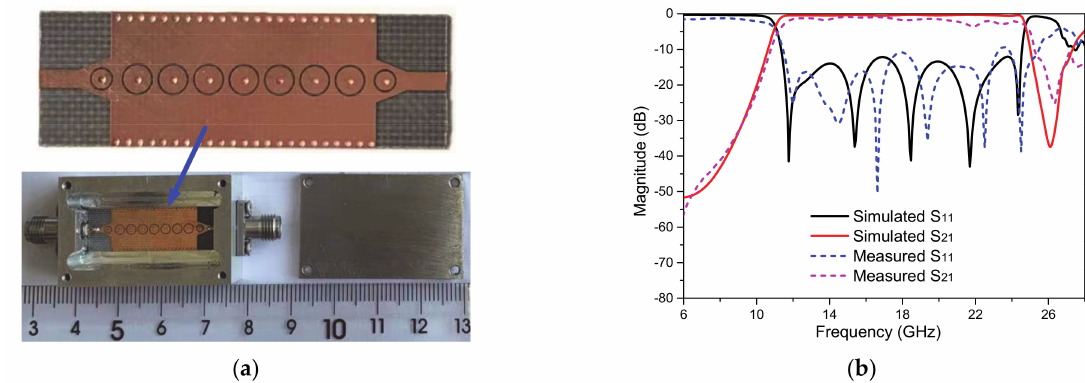
Figure 7. ( a ) Fabricated photograph of the second BPF example. ( b ) Its simulation and measurement